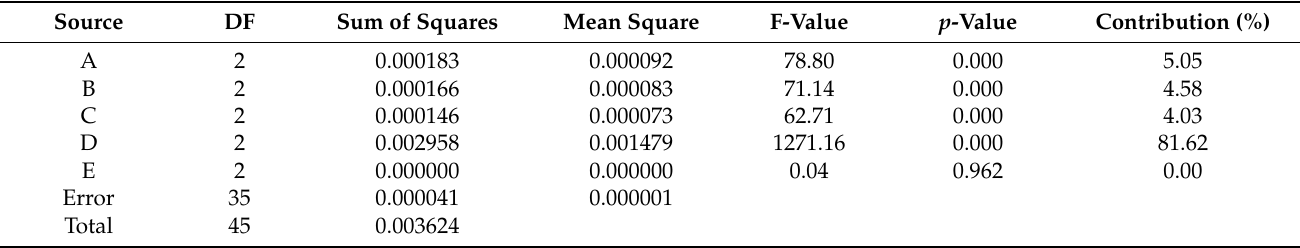
Table 9. ANOVA for maximum Table 10. ANOVA for volume shrinkage.